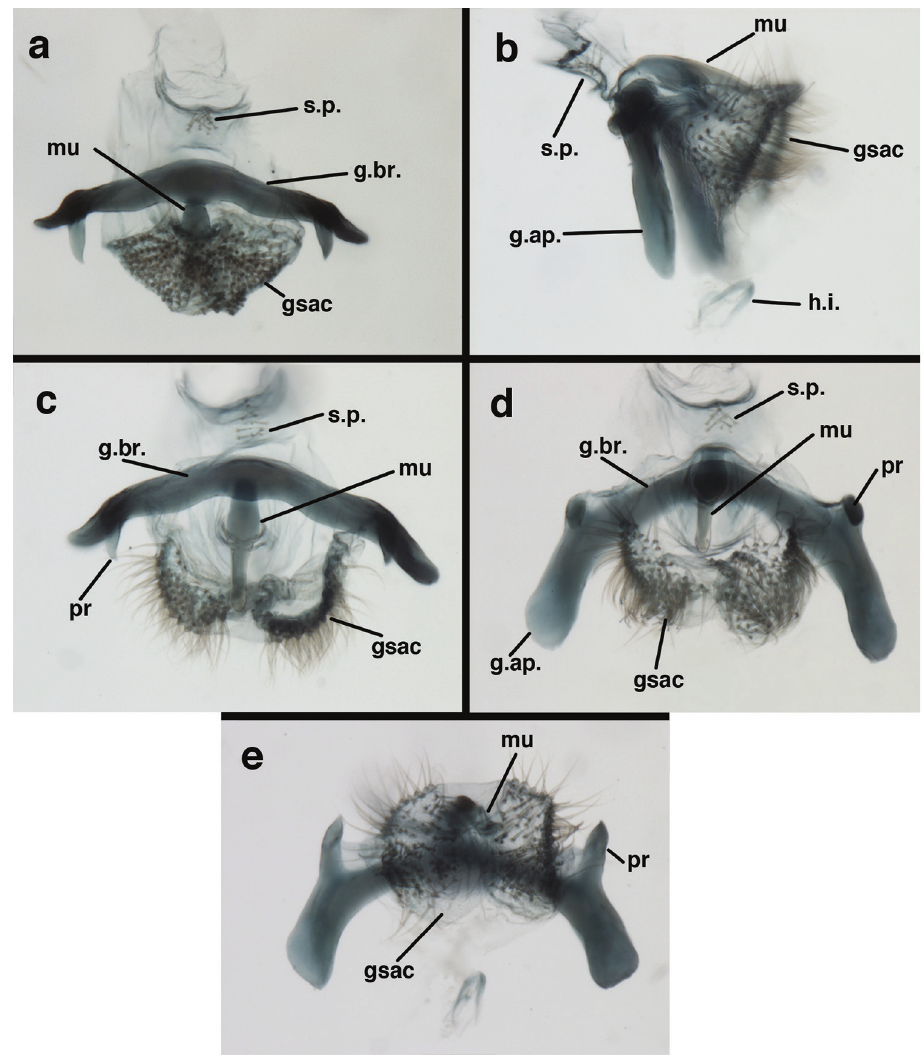
Figure 9. Ungla adamsi Tauber , sp. n. Male genitalia (mature), ( a, b ) gonosaccus unexpanded, dorsal ( a ) and lateral ( b ) ( c, d, e ) gonosaccus expanded, sequence of gonarcus rolling backward from dorsal view ( c ) to frontal view ( e ). g.ap. gonarcal apodeme g.br. gonarcal bridge gsac gonosaccus h.i. hypandrium internum mu mediuncus pr unarticulated process on frontal margin of gonarcal apodeme s.p. setose subanal plate (all: Peru, Machu Picchu; a paratype, FSCA; b–e holotype, FSCA).